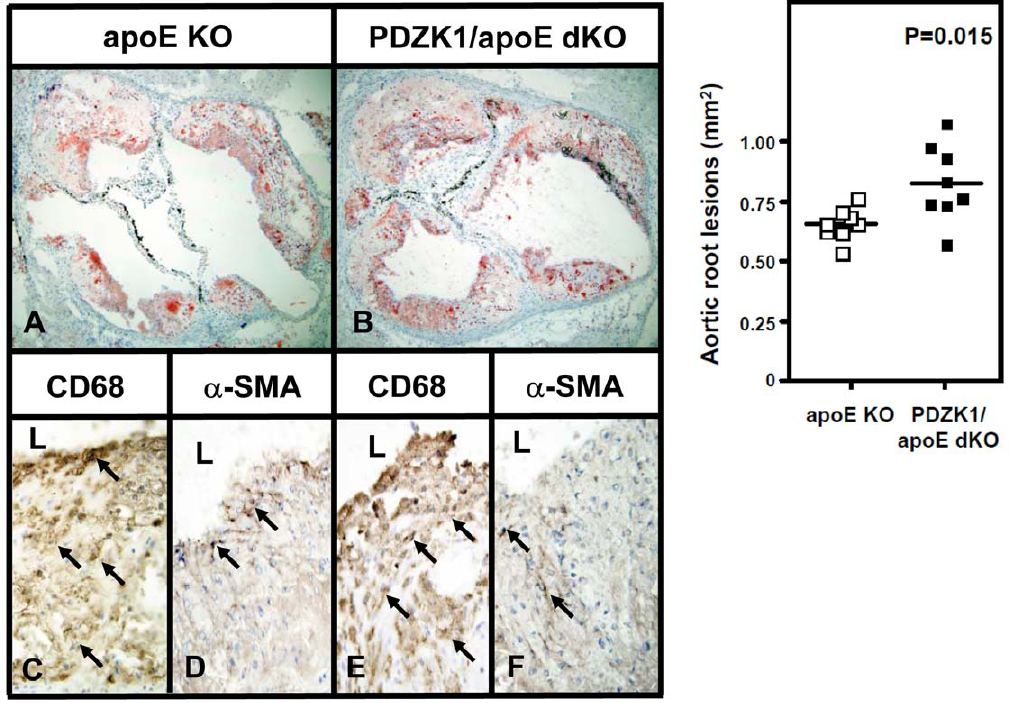
Figure 3. Aortic root atherosclerosis in Paigen diet-fed apoE KO and PDZK1/apoE dKO mice. Hearts were harvested from Paigen diet-fed apoE KO (A, C–D) and PDZK1/apoE dKO (B, E–F) mice as described in Methods (n=8 per genotype). Left top panels: A–B: representative cross-sections of Oil red O-stained aortic root lesions. (magnification, 6 20). Right top panel: quantification of aortic root atherosclerosis by planimetry. Unpaired Student’s t-test was used to determine statistical significance. Bottom panels: immunohistochemistry of aortic root atherosclerotic plaques using CD68 (C and E) or alpha-smooth muscle actin a -SMA) (D and F) antibodies show that macrophages compose the overwhelming cell population of aortic root atherosclerotic plaques and that smooth muscle cells are rare in both apoE KO (C–D) and PDZK1/apoE dKO (E–F) mice. ‘‘L’’ indicates the vascular lumen, arrows indicate representative positive cells (magnification, 6 100).